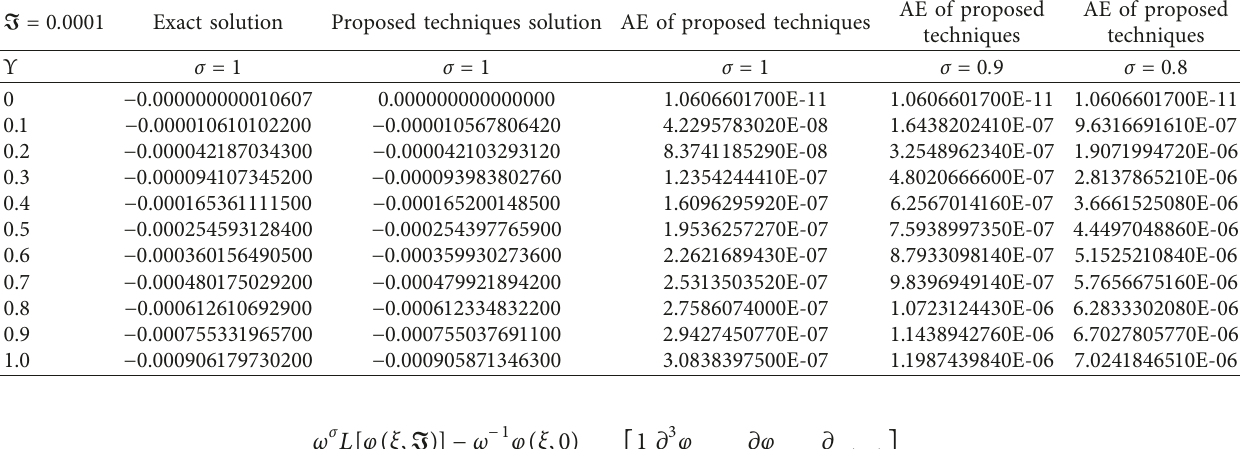
Table 2: Comparison of the proposed method and exact results with Absolute Error (AE) at various fractional order for ] ( ξ , I ) of problem